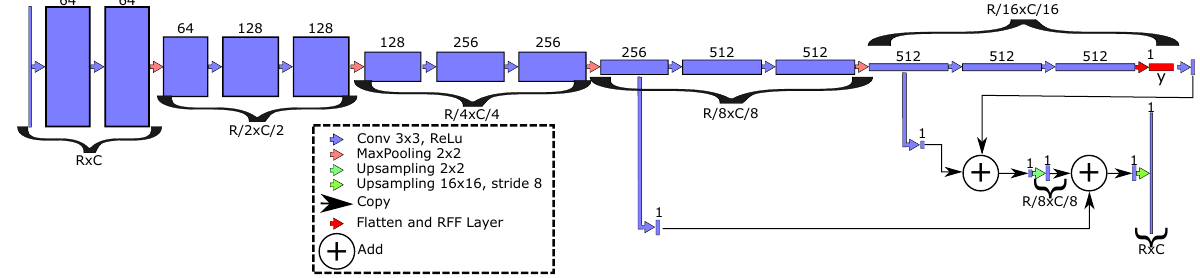
Figure 1. RFF-FCN architecture for semantic segmentation. The RFF layer is added after the last pooling (red block), number of filters, kernel size, stride, and nonlinear activation function are shown.